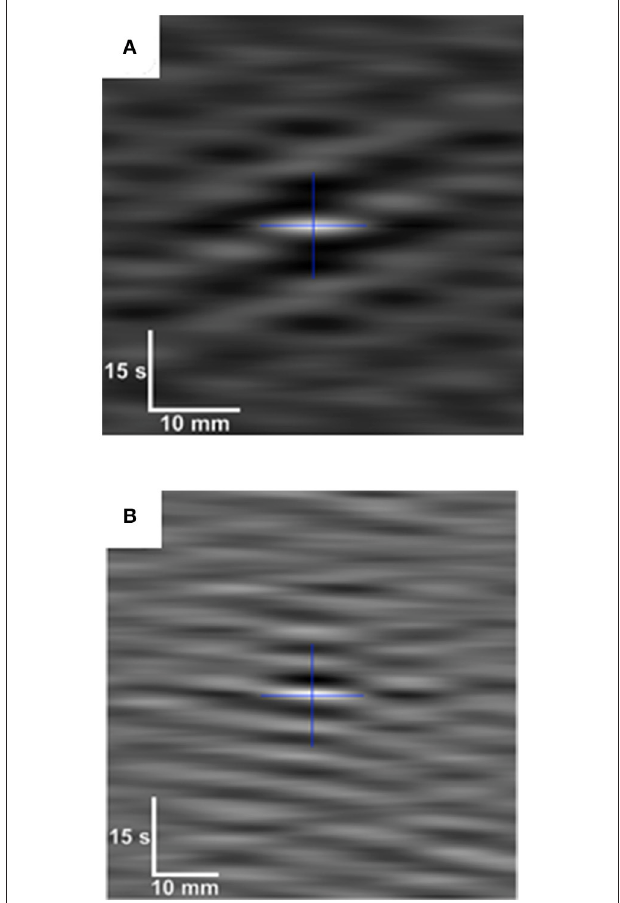
FIGURE 7 | Auto-correlogram (A) and cross-correlogram (B) of data from D-type and L-type ST maps during pendular/segmentative activity in the terminal ileum of an anesthetized pig. White indicates high levels of correlation and darker shades lower correlation. The cross indicates the geometric center of each correlogram. The auto-correlogram (A) , which is from a subsection of an L map of ileal motility, shows a pattern in which a longitudinal contraction at a particular point along the gut occurs with every second or third wave of the base frequency (center). Hence, the variability in the spacing between lighter (contraction) bands at all points around the single central band of the base frequency, indicates local variability in contractile responses to slow waves. The cross correlogram (B) (bottom) is derived from synchronous subsections f of D-type and L-type ST maps of ileal motility. It shows an underlying pattern of regular spacing between contractile events at all points around the central band of the base frequency indicating that the two events likely result from a common initiating signal. Figure adapted from Janssen et al.